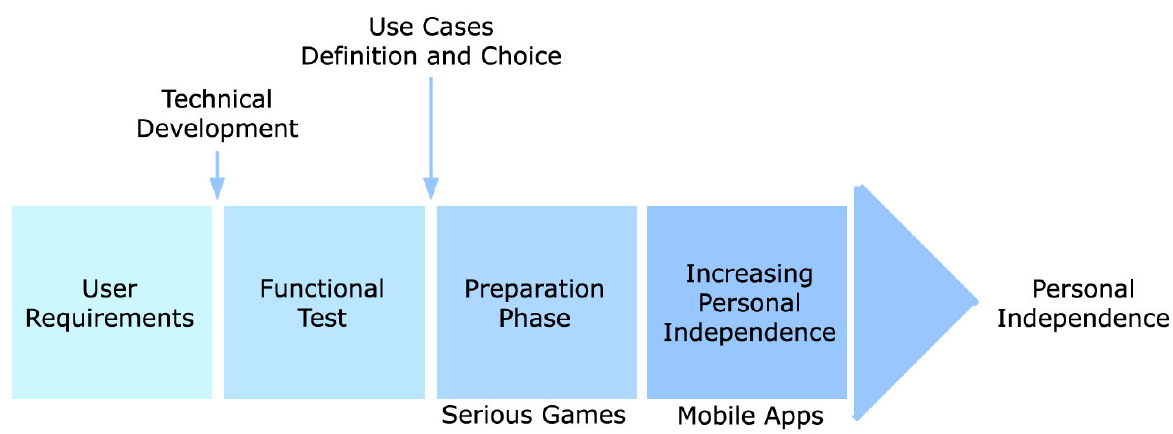
Figure 2. Smart Angel: planning of the